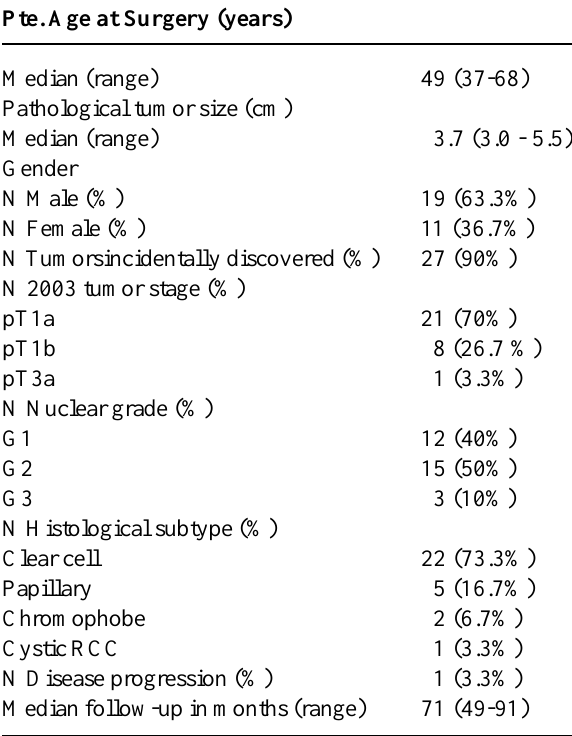
Table 1 – Clinicopathological characteristics of 30 pa-